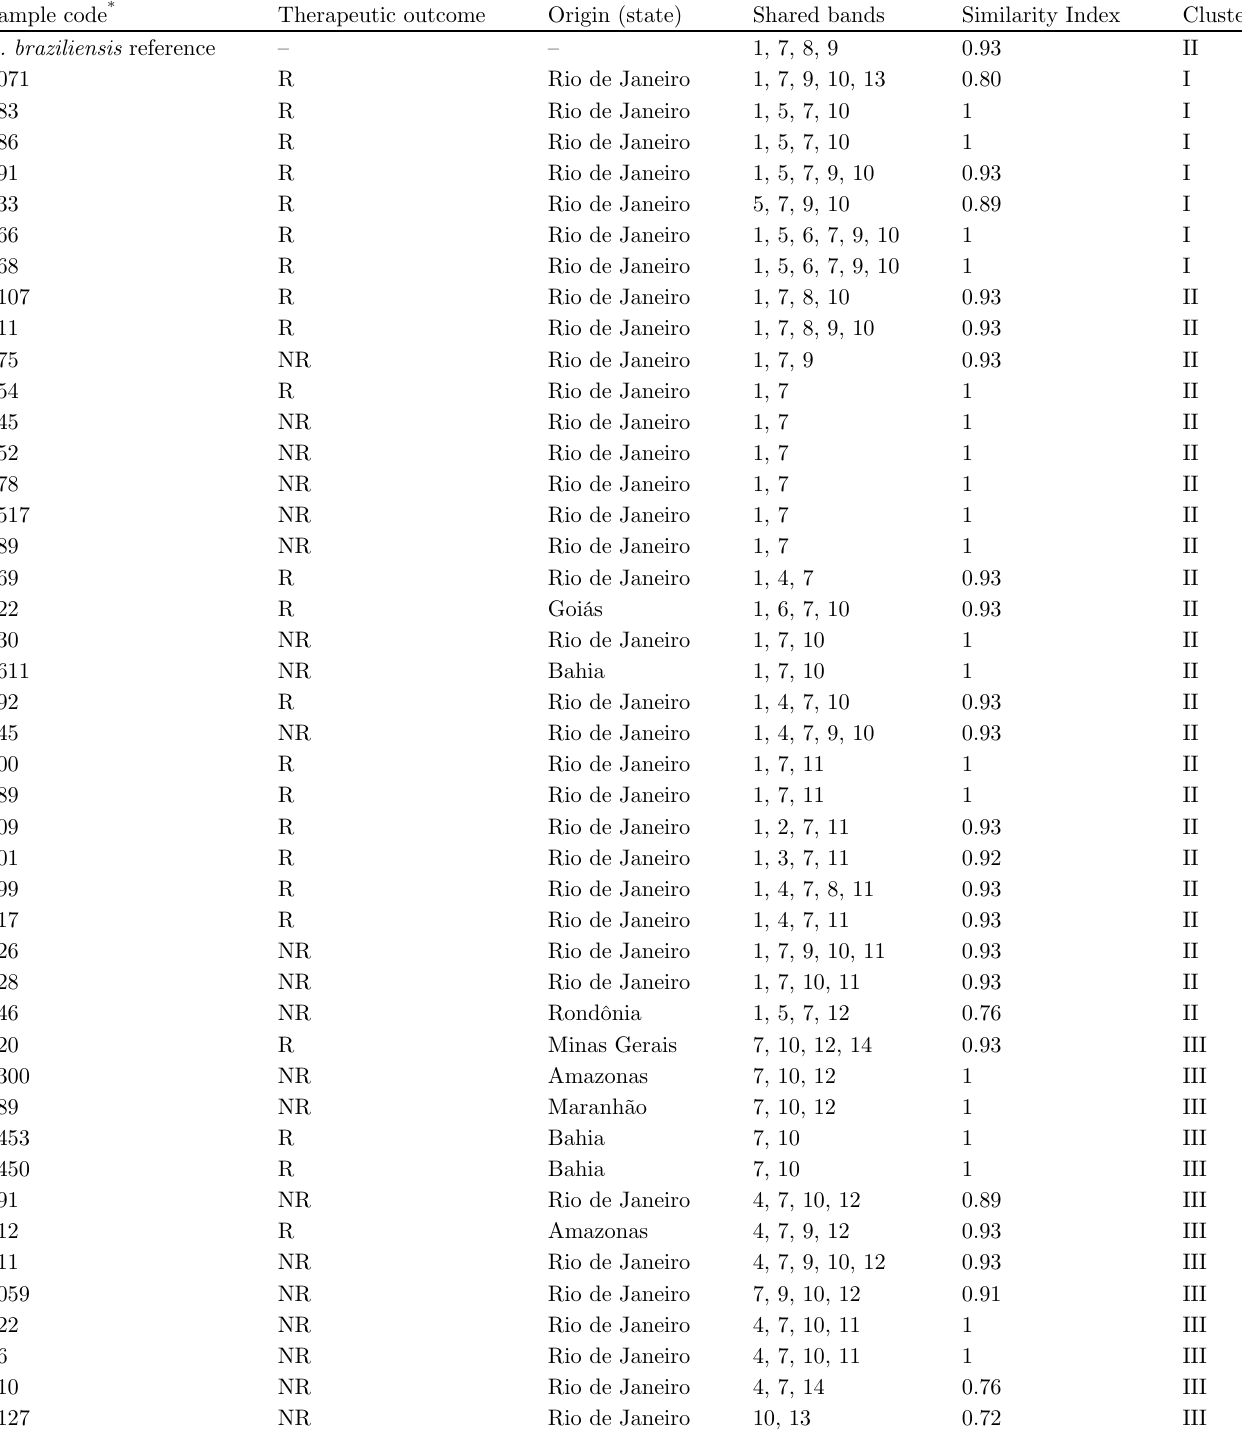
Table 2. Data obtained from genetic analyses of all the 44 samples of Leishmania (Viannia) braziliensis